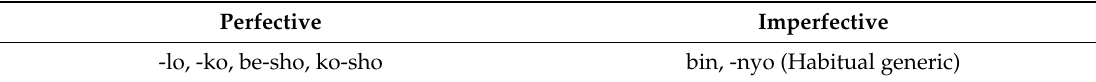
Table 2. Aspectual marking in